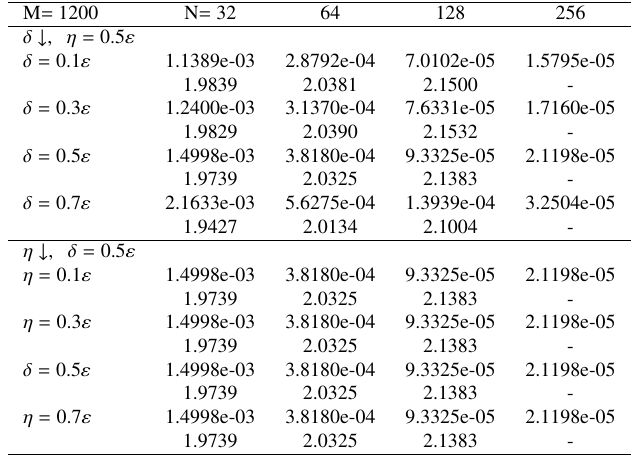
Table 3. Example 4.1, maximum absolute error and rate of convergence for ε = 2 − 2 . M = 1200